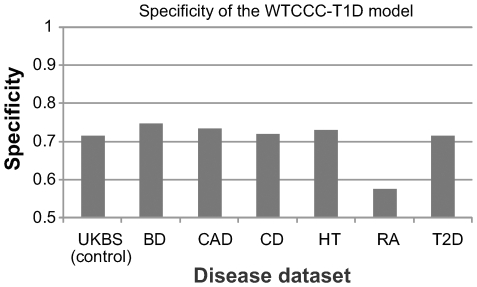
Specificity of the SVM-based risk assessment models.The risk assessment models were parameterized on the WTCCC-T1D dataset and evaluated on other disease cohorts from WTCCC, including bipolar disorder (BD), coronary heart disease (CAD), Crohn's disease (CD), hypertension (HT), rheumatoid arthritis (RA), and type 2 diabetes (T2D). The specificity measure was calculated with default cutoff of zero point. Except for RA, the specificity measures of the prediction model are comparable for other diseases as that for the control subjects.